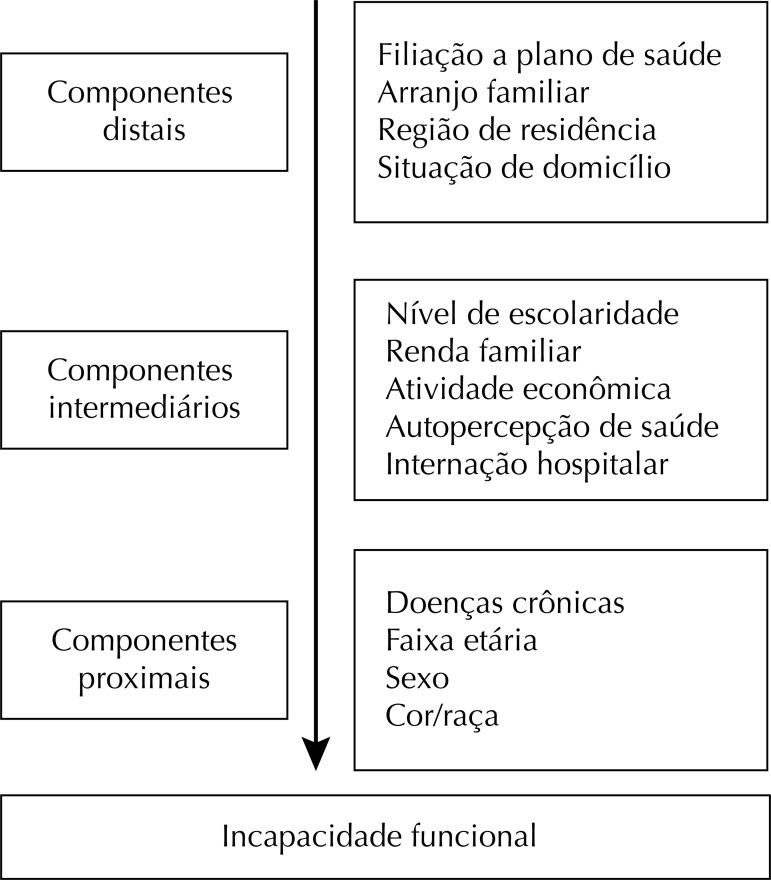
Esquema gráfico do modelo hierárquico empregado na análise ajustada. Brasil, 2015.